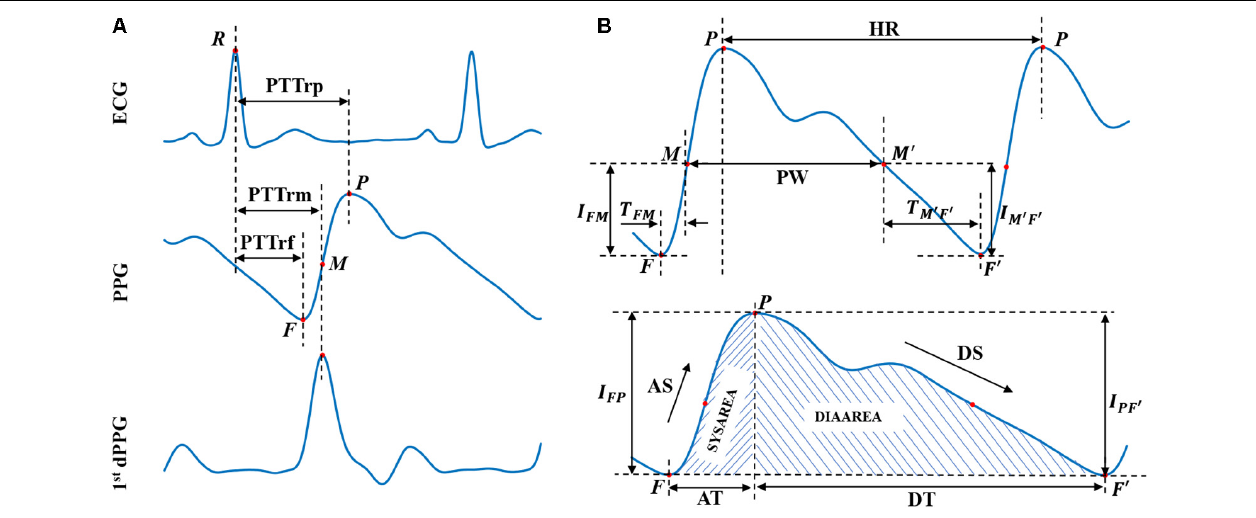
FIGURE 2 | Extracted physiological features from ECG, PPG, and 1st dPPG in a cardiac cycle. First dPPG indicates the first derivative of PPG. (A) PTT values extraction. (B) PPG features extraction. R represent the R-wave peak of ECG; F / F (cid:48) and P represent the foot and peak of the PPG waveform, respectively, and letter M (and its corresponding point M (cid:48) ) represents the peak of the first derivative of PPG. Abbreviations and detailed definitions show in Table 1